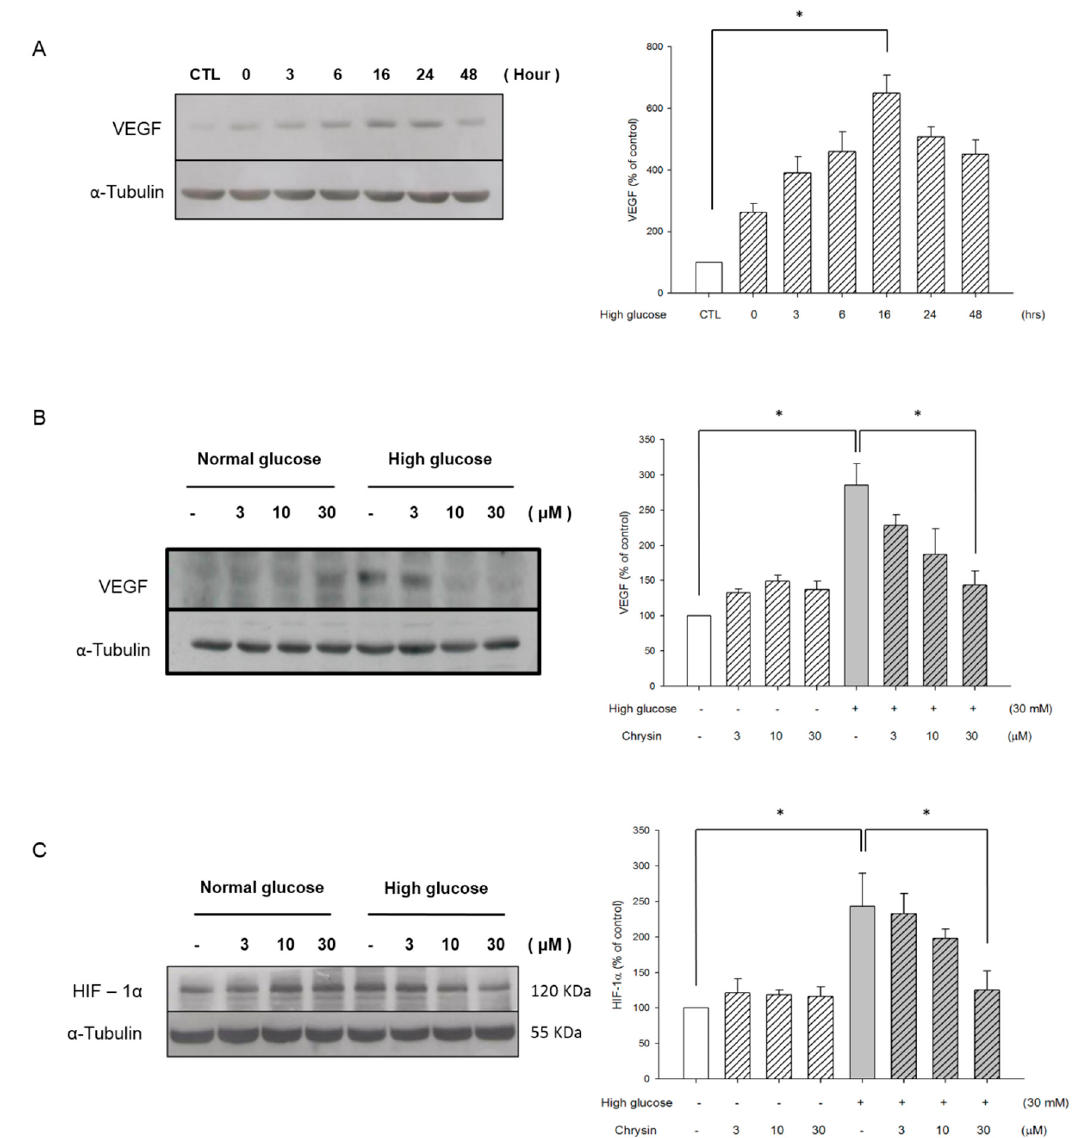
Figure 6. Chrysin Inhibited the HIF-1 α and VEGF expression. ( A ) The time course for VEGF expression levels induced by high glucose. RF/6A cells were cultured in the high glucose medium (30 mM) and harvested at different time points (0, 3, 6, 16, 24, 48 h). Subsequently, a western blot analysis was performed for the expression levels of VEGF with the quantification data being displayed on the right panel. ( B ) The effects of the intracellular expression levels of VEGF with chrysin treatment and high glucose with the quantification data being shown on the right panel. ( C ) The effects of the expression levels of HIF-1 α with chrysin treatment and high glucose with the quantification data being shown on the right panel. All data was acquired by means of ± SE from at least three independent experiments. * p < 0.05, vs. control.